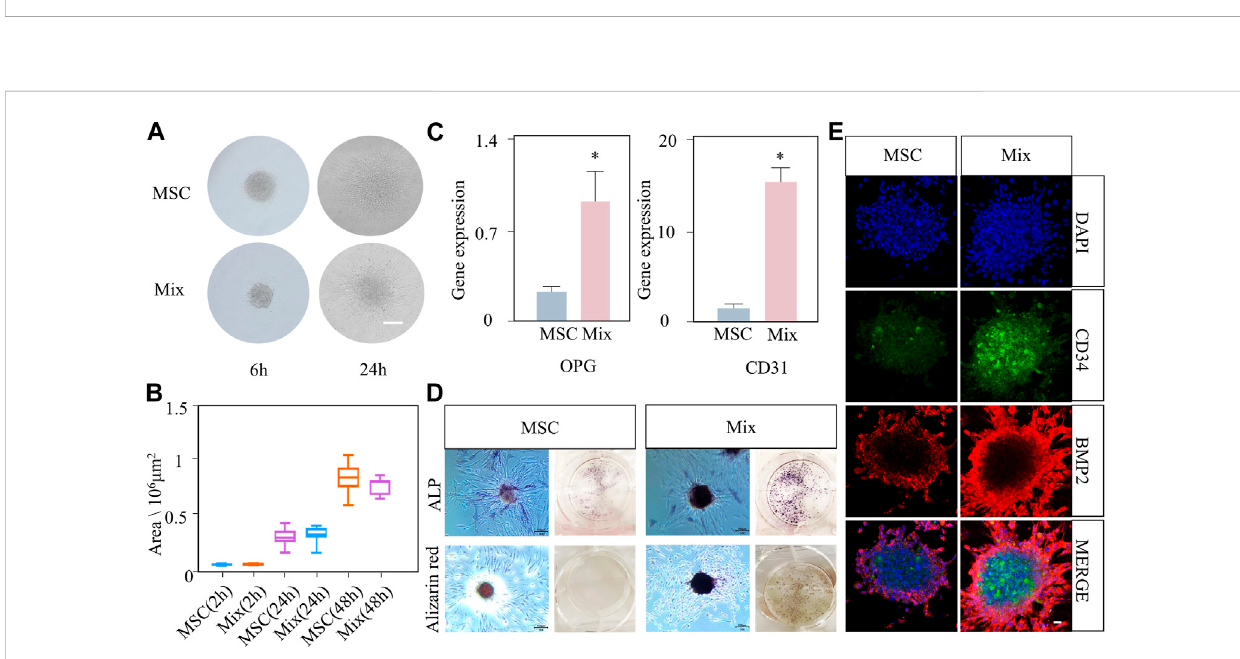
FIGURE 2 The active spreading and osteogenic abilities of MSC-EC mixed spheroids (Mix) were stronger than that of MSC spheroids. (A, B) Light microscope images of budding experiment, and the statistical data of spheroid area change with time in the Mix and MSC groups. Scale bar: 100 μ m. (C) qPCR results of OPG and CD31 gene expression at 3 days of culture. (D) ALP staining and alizarin red staining images taken at 3 or 10 days of spheroid culture. (E) Immuno fl uorescence exhibiting the expression of CD34 and BMP2 in the Mix and MSC groups. Scale bar: 10 μ m * ( p < 0.05) indicate statistically signi fi cant